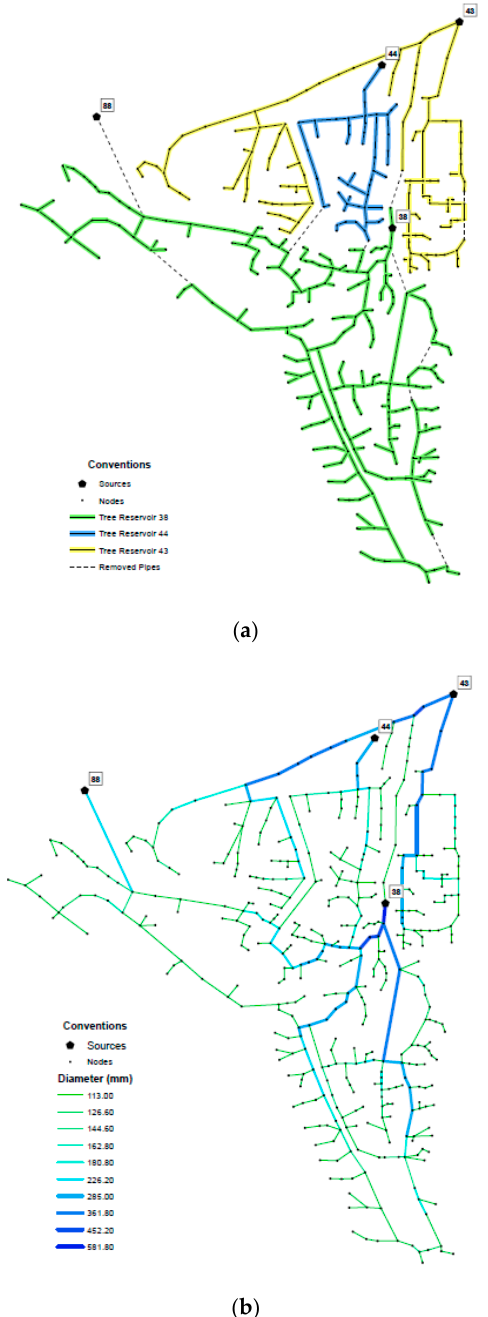
Figure 10. ( a ) General layout for Balerma network and the spanning tree obtained for each reservoir, including the removed pipes. Dashed lines are pipes from the original networks that are not included in the Spanning Tree ( b ) OPUS design for Balerma Network. The diameters are shown in millimeters.